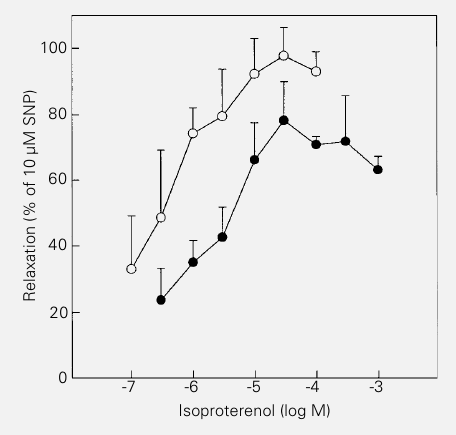
Figure 7 - Relationship between the magnitude of relaxation in- duced by different concentra- tions (M) of isoproterenol in iso- lated lower esophageal sphinc- ter (filled circles) and ileocolonic junction (open circles) strips. Data are reported as the mean ± SEM (N = 6). The relaxation mag- nitude is reported as % of that obtained with sodium nitroprus- side (SNP). All experiments were performed in the presence of 1 µM atropine and 3 µM guanethi-